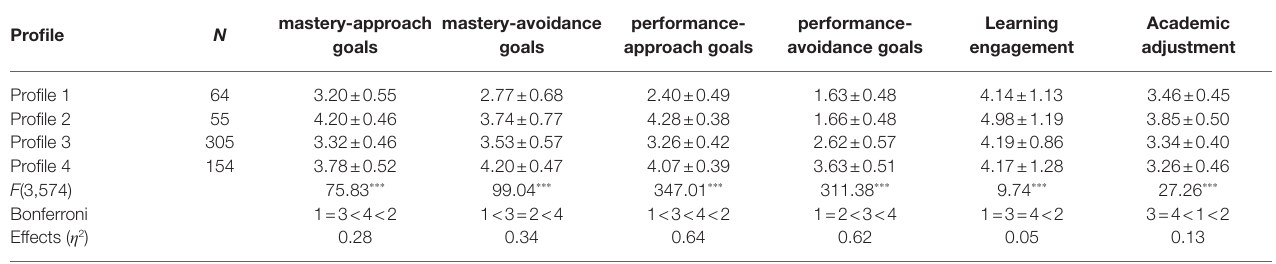
TABLE 3 | Descriptive statistics (means ± standard deviations), MANOWA, and post-hoc analyses of the relationships between latent profile analysis membership, achievement goal orientations, learning engagement, and academic adjustment. Profile N